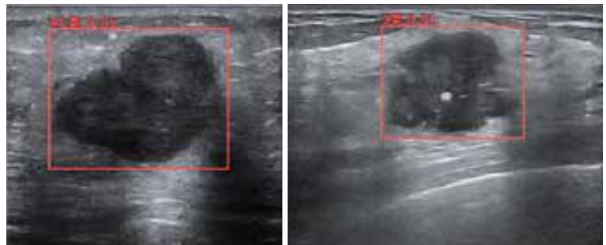
Figure 2 Example of breast ultrasound artificial intelligence aided diagnosis system automatically identifying breast nodules and prompting benign and malignant risks. Note: AI system diagnosed that the nodule may be malignant, and the risk probability value is 0.85 (BI-RADS 4c) and 0.91(BI-RADS 5), marked with red